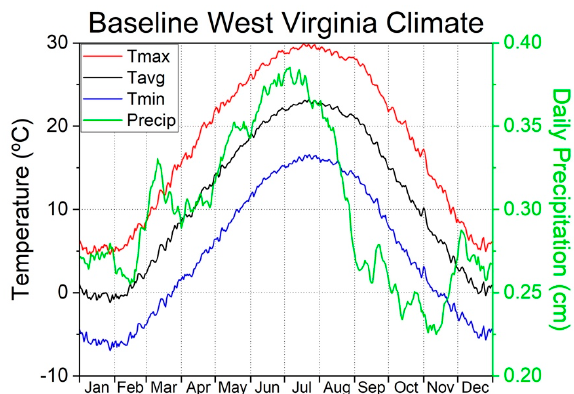
Figure 2. Daily average maximum temperature (Tmax), minimum temperature (Tmin), average temperature (Tavg), and precipitation (Precip) over a long period of record (1900–2016) averaged across eighteen observation locations in West Virginia, USA. Daily average precipitation data were smoothed with a centered three-week moving average for plotting purposes.